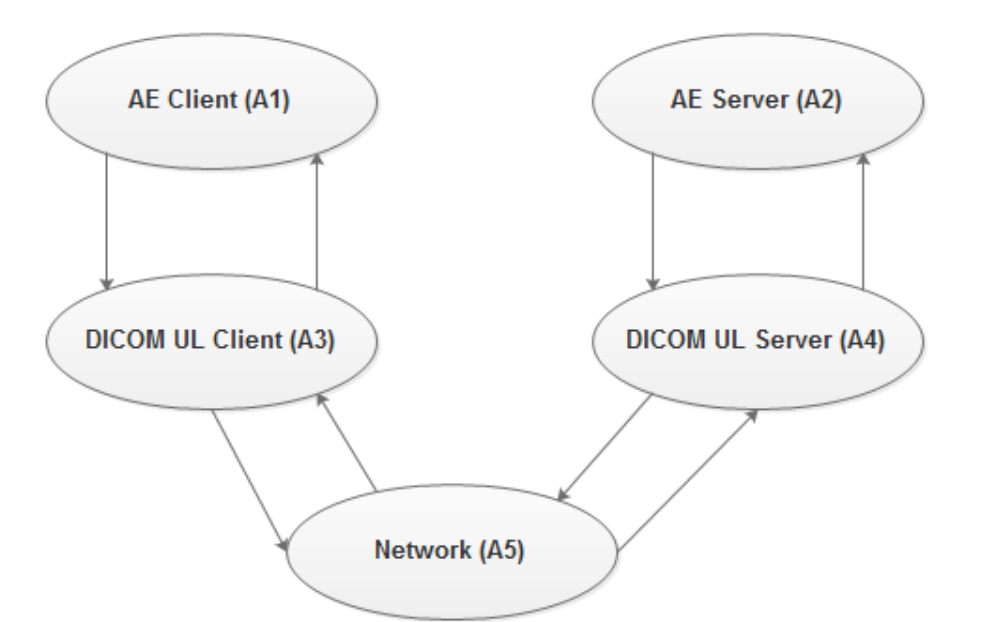
Fig. 6. MIS reliability estimation problem hierarchy